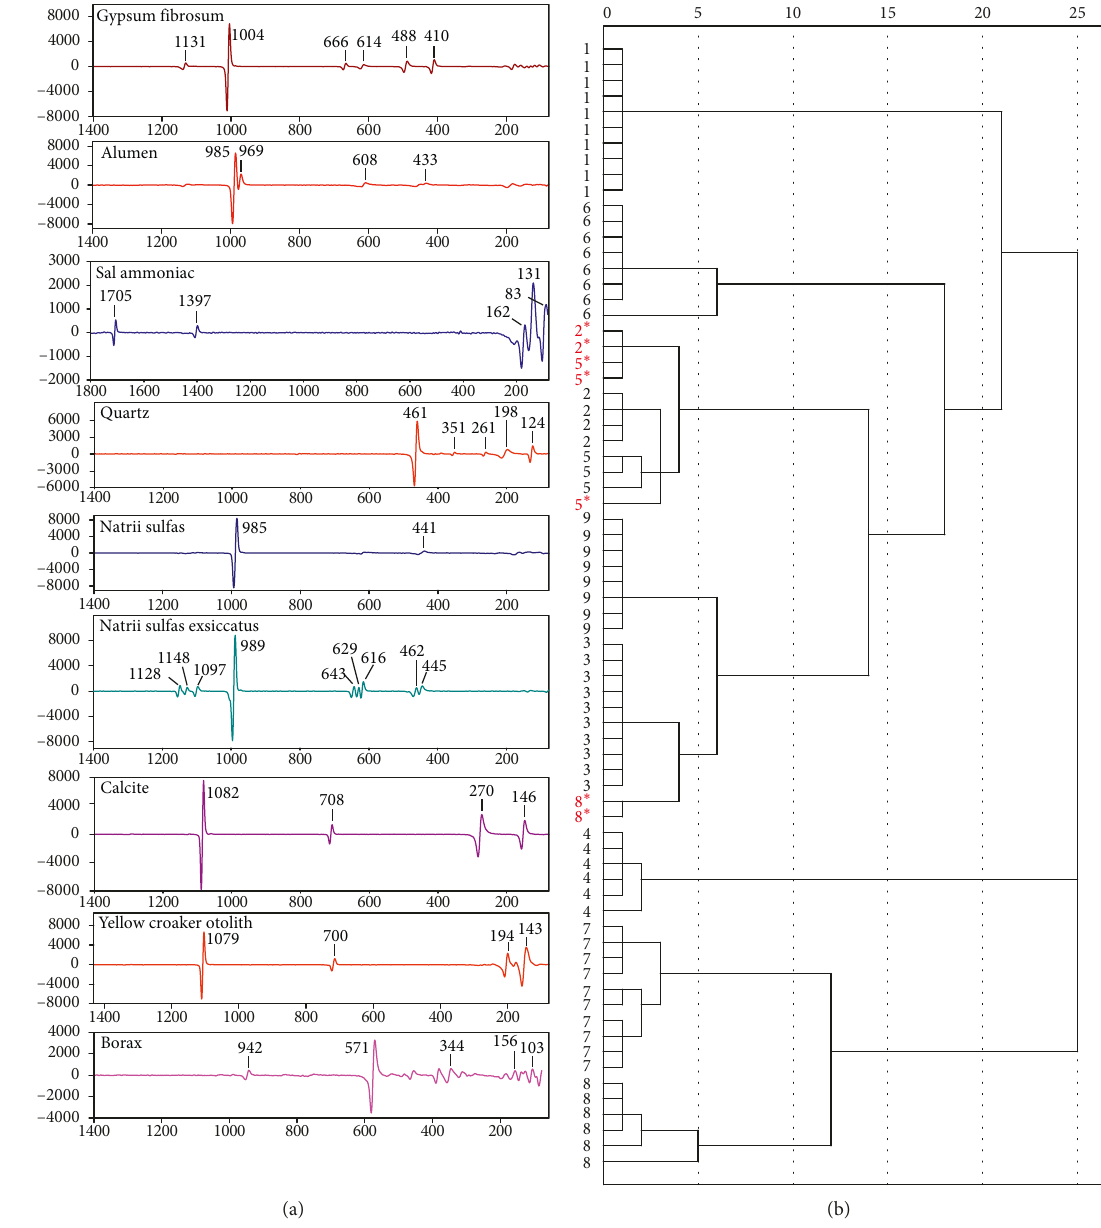
Figure 3: (a) Peaks selected from spectra pretreated by FD. (b) The dendrogram ( ∗ samples which were clustered